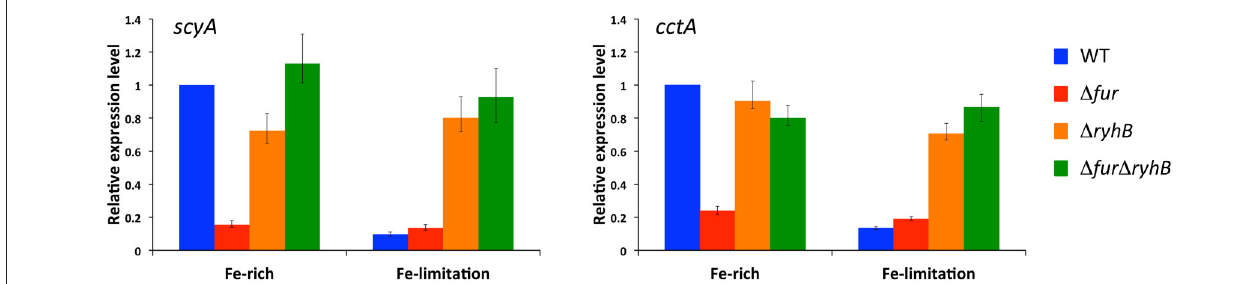
FIGURE 2 | Expression of scyA and cctA is regulated by iron-availability through Fur and RyhB. Transcript levels were assessed by qRT-PCR in S. oneidensis wild-type, 1 fur , 1 ryhB , and 1 fur 1 ryhB strains in rich medium (iron-rich) and after 30min growth with the iron chelator 2,2 ′ -dipyridyl (iron-limitation). Transcript levels are shown relative to wild-type level in rich medium as expression ratio of four technical replicates (error bars, standard error). Results from an independent experiment are shown in Supplementary Figure 3.